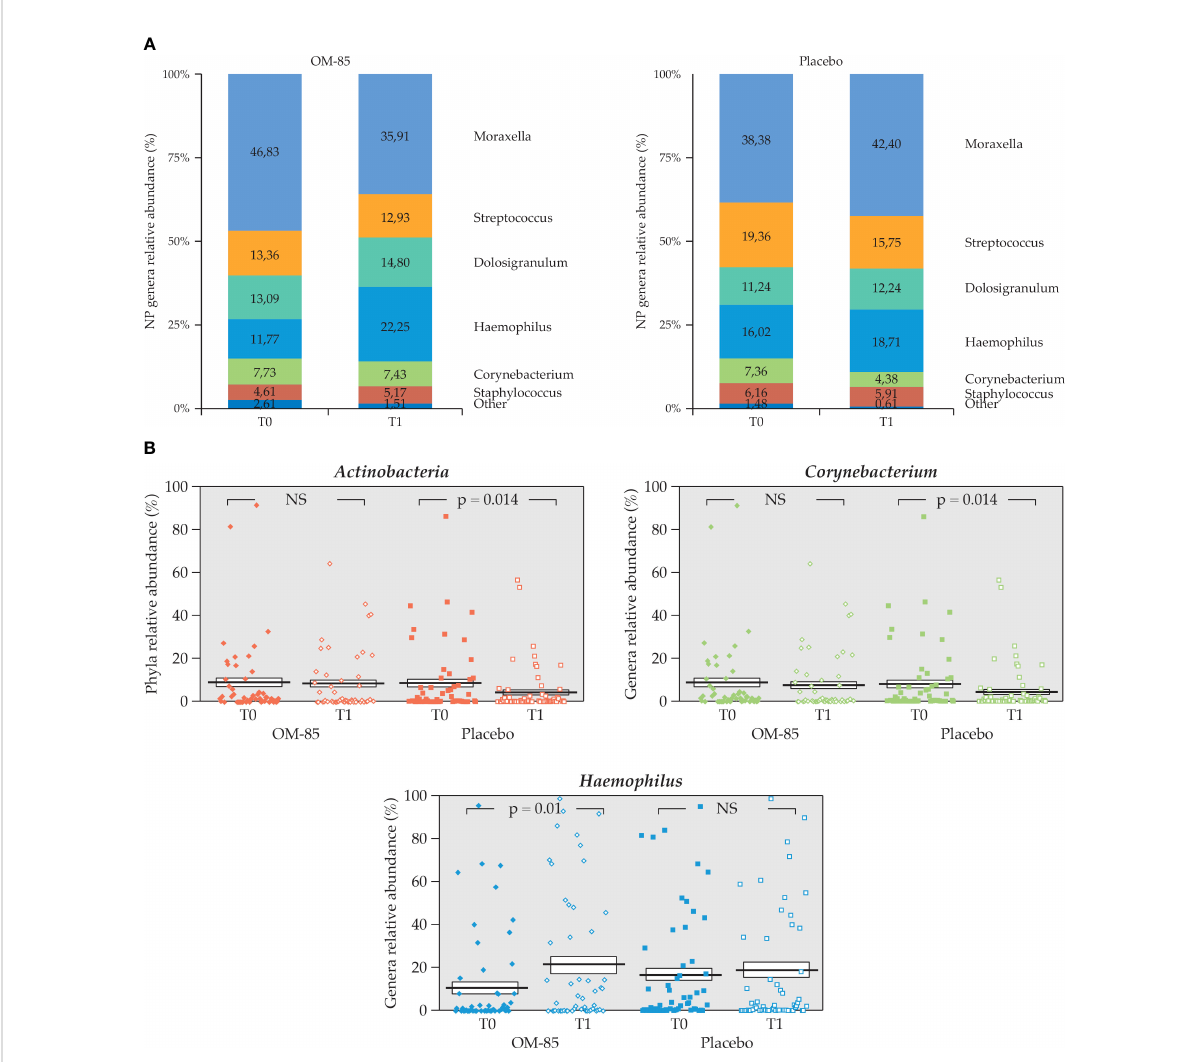
FIGURE 10 Intra – group change of NP microbiota relative abundance in OM – 85 and placebo groups in the subgroup of children aged ≥ 2 years ( n = 111). (A) NP microbiota pro fi les at T0 and T1 for both treatment groups (n=52, OM-85 and n=59, placebo). (B) Statistically signi fi cant intra – group difference in relative abundance for Actinobacteria phylum, and Corynebacterium in placebo and Haemophilu s genera in OM-85 (Wilcoxon ’ s signed – rank test). NS, not signi fi